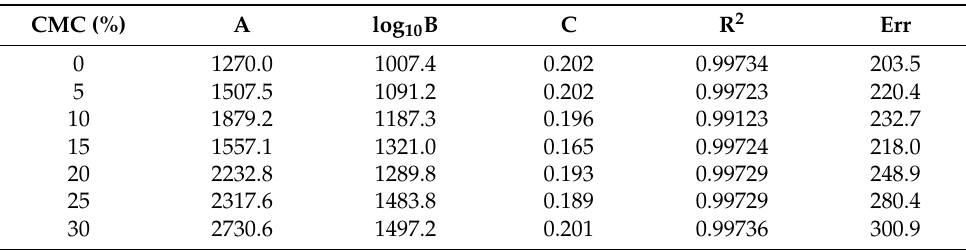
Table 3. Parameters of the fittings of the T 1 distributions, using a log-Gaussian function, presented in Equation (4).